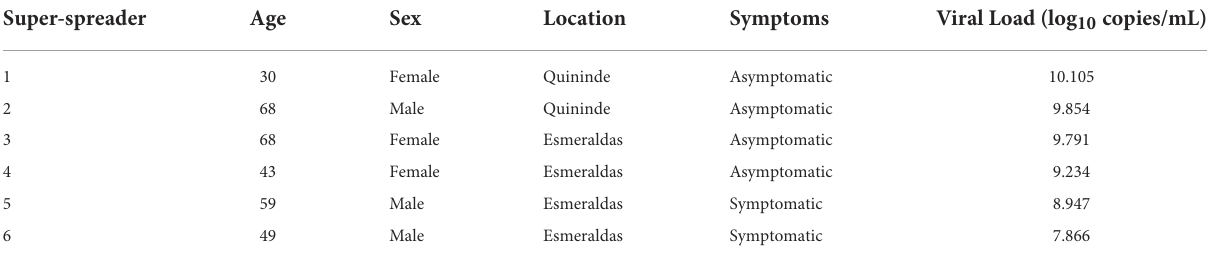
TABLE 2 Demographic and clinical information from the